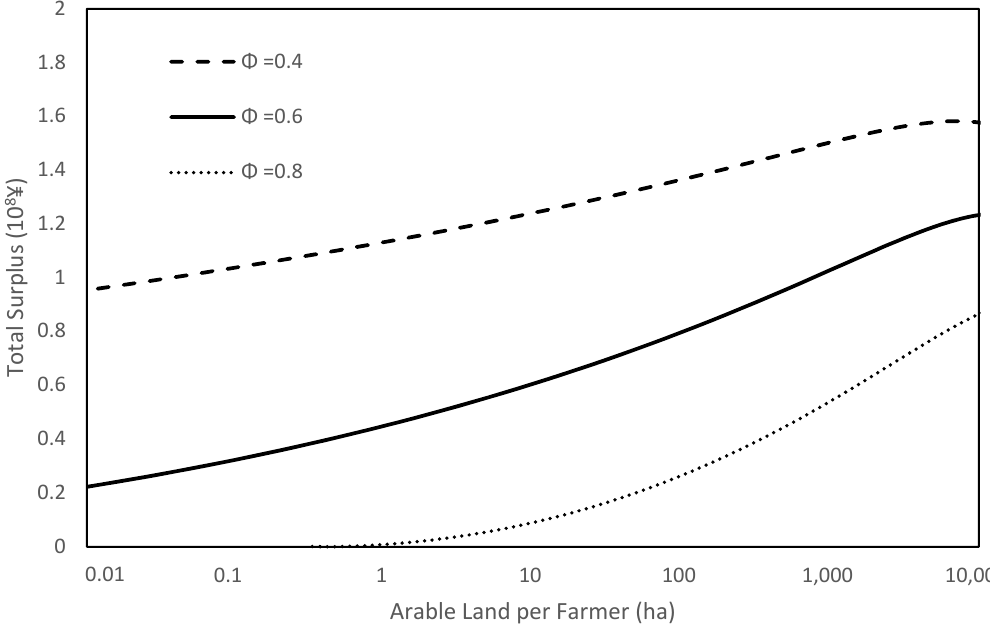
Figure 5. Relation of ALPF to total surplus. Note: Total surplus is calculated using the supply and demand curves, Equations (14) and (15) in Section 3.1.